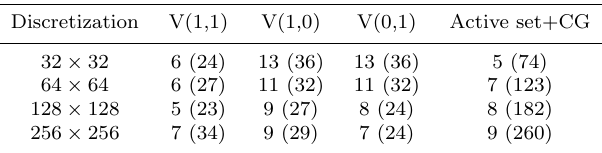
Table 3. Hertzian contact: the total number of active set iterations by FMG on the target grid and by the original method, with the numbers of work units in brackets.